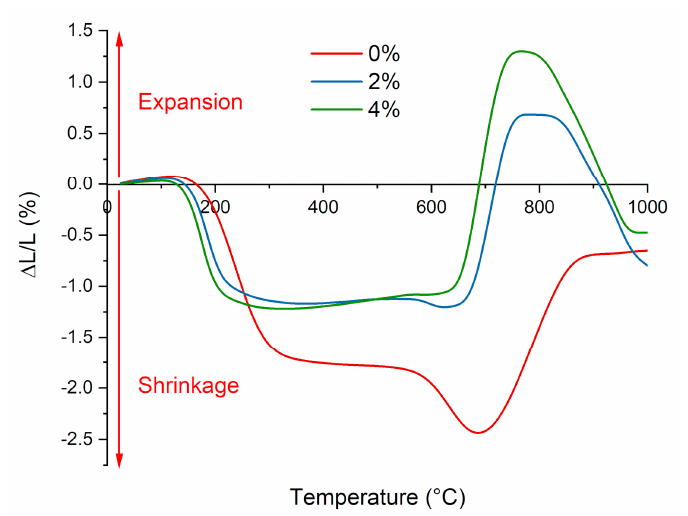
Figure 6. Dilatometry curves of fly ash geopolymers with varying silica fume content from room temperature to 1000 °C.